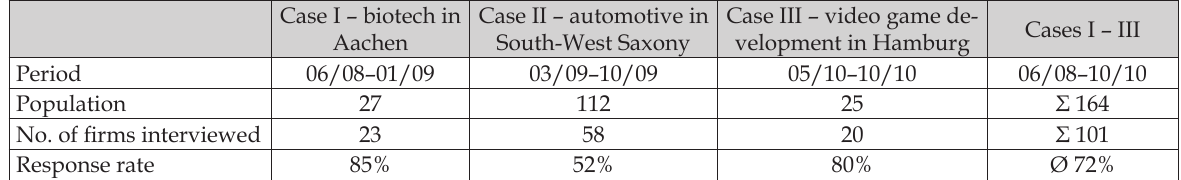
Table 2. Overview of firm interviews.